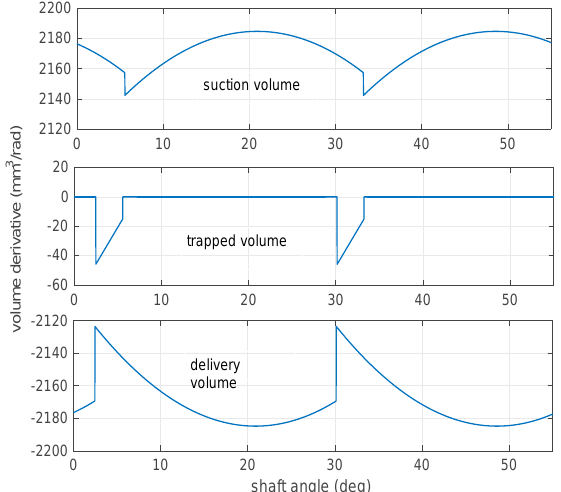
Figure 18. Derivatives of delivery, suction and trapped volumes vs. shaft angle.